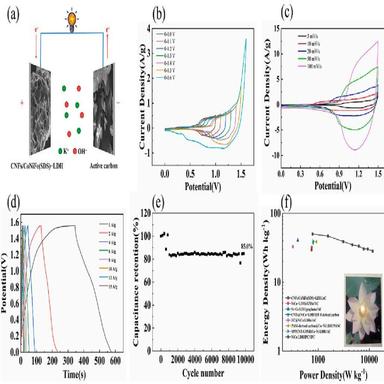
(a) The schematic of CNFs/CoNiFe(SDS)–LDH//AC ASC; The electrochemical test of CNFs/CoNiFe(SDS)–LDH//AC ASC, (b) CV curves within different voltage windows at 5 mV s − 1 ; (c) CV curves at various scan rates; (d) GCD curves at different current densities; (e) Cycling life at 10 A g− 1 and (f) Ragone plot of the ASC device compared to the previously reported ASCs.